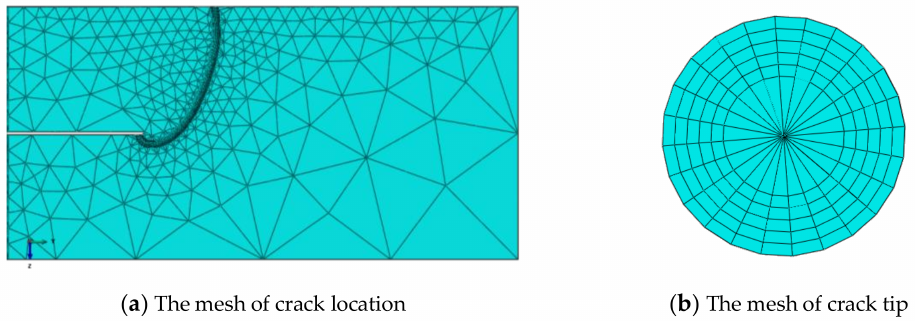
Figure 16. The geometry and boundary conditions of the specimen.